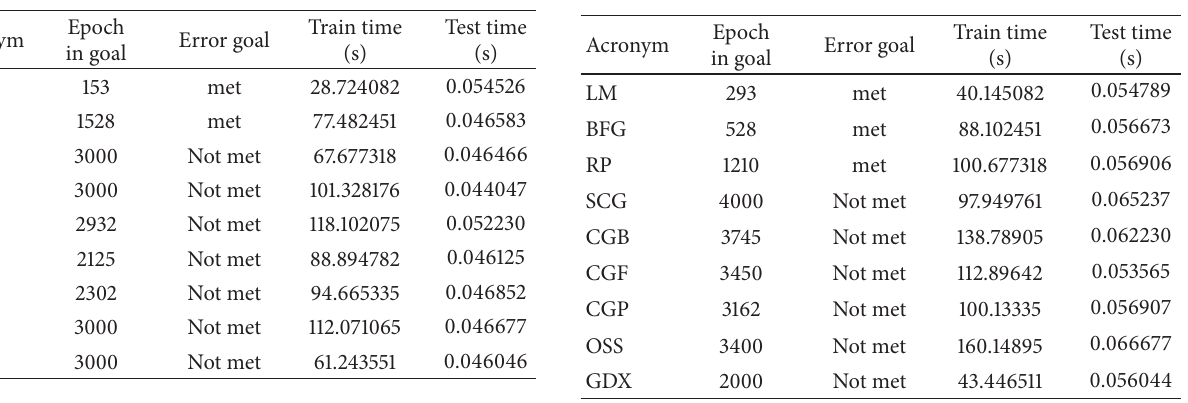
Table 8: The results of the variable training methods in the BPN with newff